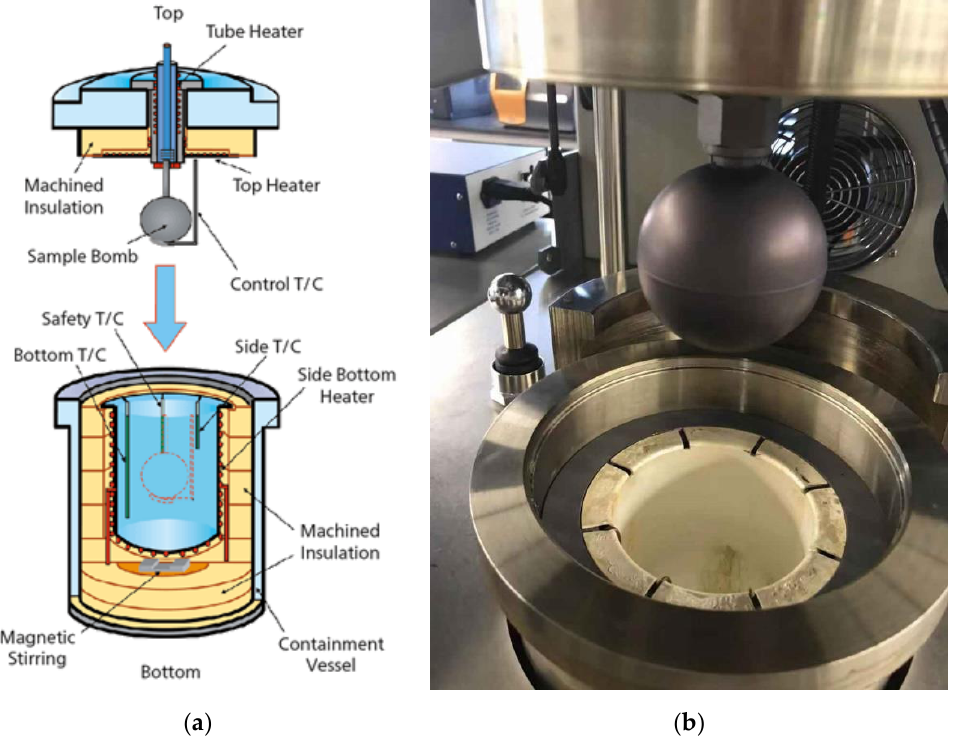
Figure 1. Scheme ( a ) and photo ( b ) of Netzsch APTAC chamber. 1 — machined insulation; 2 — sample bomb; 3 — safety thermocouple; 4 — bottom thermocouple; 5 — magnetic stirring; 6 — containment vessel; 7 — machined insulation; 8 — side bottom heater; 9 — side thermocouple; 10 — control thermocouple; 11 — top heater; 12 — tube heater.